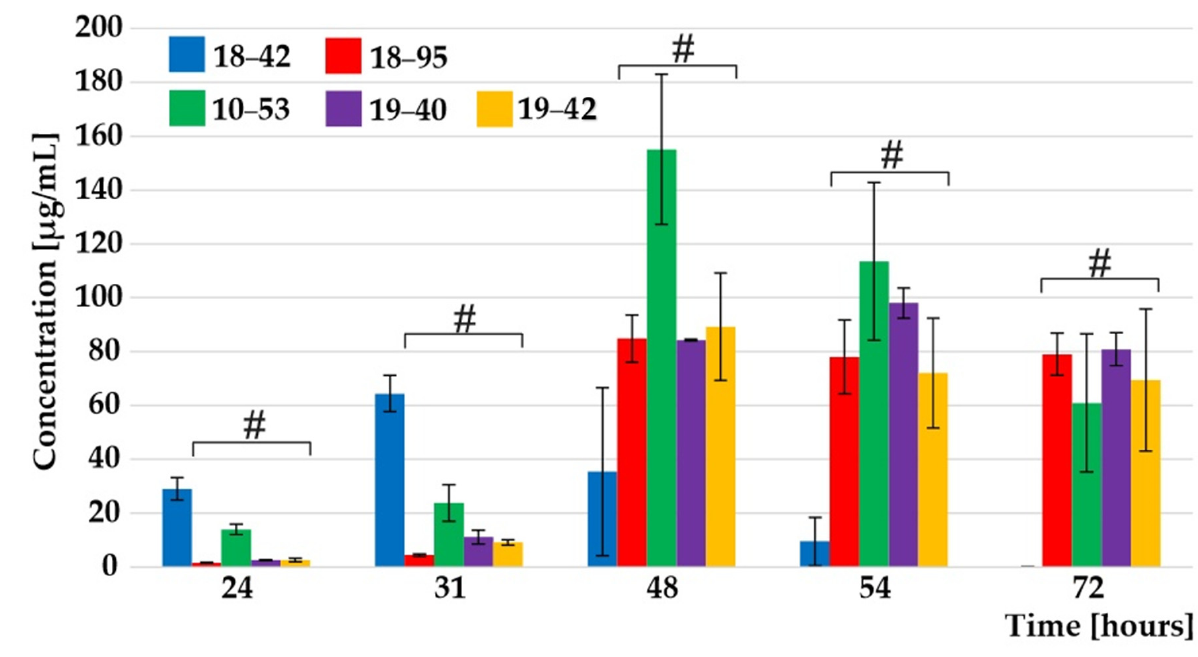
Figure 1. TafC time-related data in A. fumigatus supernatant. The VF A. fumigatus secretes TafC earlier than the VI strains, indicated by an # symbol. The error bars indicate the standard error of the mean, n = 9. See also Supplementary Materials Table